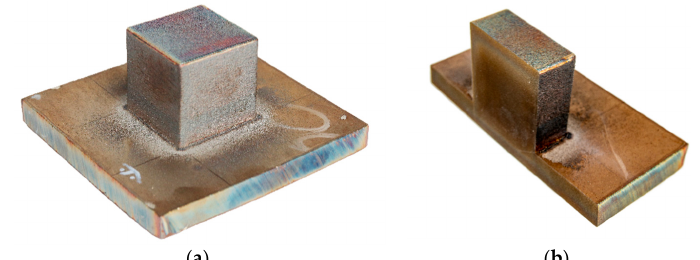
Figure 4. ( a ) Printed sample ( b ) Cut sample for Contour method measurement.